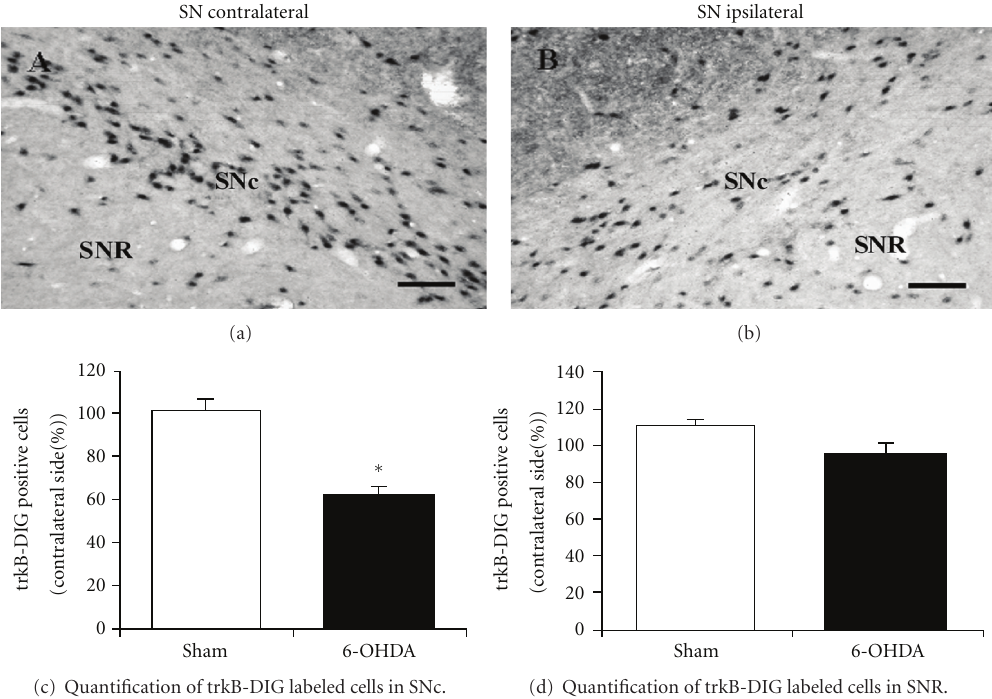
Figure 4: A specific decrease in the number of positive trkB-mRNA cells is observed in ipsilateral SNc 7 days after unilateral 6-OHDA intrastriatal injections. Photomicrographs from ISH experiments show trkB-DIG positive cells in the contralateral side (a) and ipsilateral side (b) of rat SN 7 days after unilateral 6-OHDA intrastriatal injection, respectively. (a), (b) scale bar = 100 μ m. SNc: substantia nigra pars compacta; SNR: substantia nigra pars reticulata. (c) Percentage of trkB-DIG positive cells in the ipsilateral SNc compared with the contralateral side, 7 days after unilateral intrastriatal 6-OHDA (black columns) or ascorbic acid (sham, white columns) injections to rats. Number of cells with trkB-DIG-positive signals in contralateral SNc was 285 . 7 ± 15 . 9 and 317 . 5 ± 31 . 7 cells/mm 2 in ascorbate and 6-OHDA injected rats, respectively. (d) Percentage of trkB-DIG positive cells in the ipsilateral SNR compared to the contralateral side, 7 days after unilateral intrastriatal 6-OHDA (black columns) or ascorbic acid (sham, white columns) injections to rats. Number of cells with trkB-DIG positive signals in contralateral SNR was 107 . 7 ± 5 . 1 and 117 . 9 ± 5 . 1 cells/mm 2 in ascorbate and 6-OHDA injected rats, respectively. n = 4 rats under each experimental condition. The di ff erent experimental groups were compared with a Kruskal-Wallis nonparametric ANOVA, followed by a U -test. ∗ P < 0 . 05 compared with sham-treated